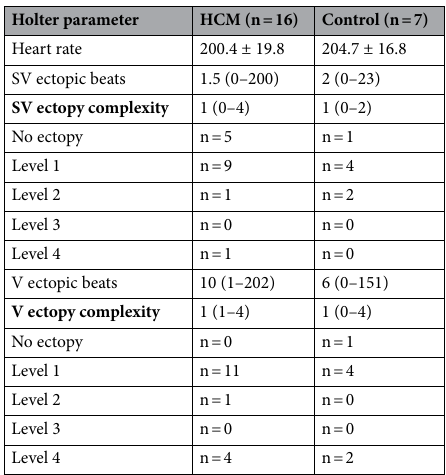
Table 3. Ectopy frequency and complexity for the 23 cats for the entire recordings based on group. Data are displayed as median (minimum–maximum) and the number of cats with each complexity level.